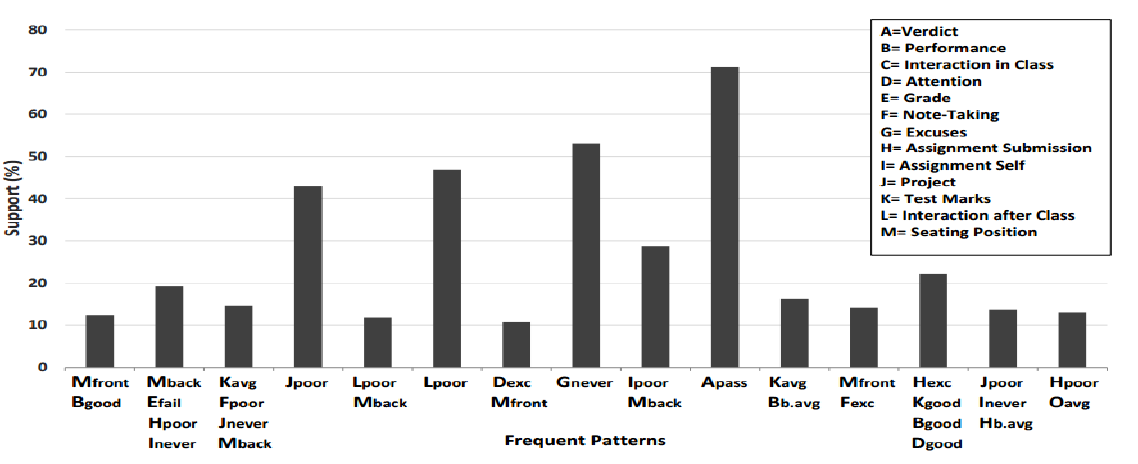
FIG. 3: PATTERNS IN THE COMPLETE DATASET